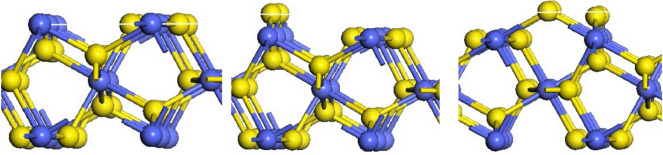
Different terminations of the CoS2 (220) surface.